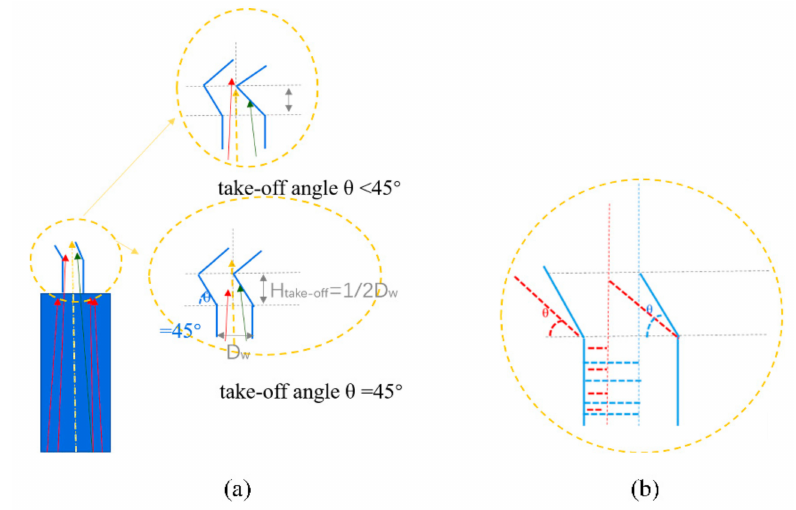
Figure 6. ( a ) The upper and lower dendrites at the critical take-o ff angle of 45 ◦ and ( b ) the comparison of red and blue dendrites growth channel with related take-o ff angle